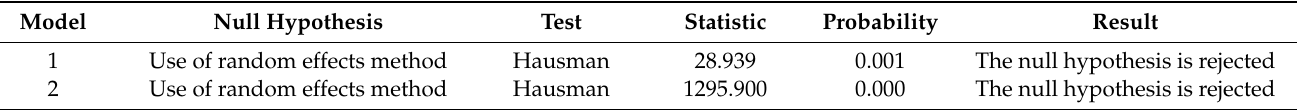
Table 3. The conducted Hausman test for determining the random effects model against the fixed effects model.